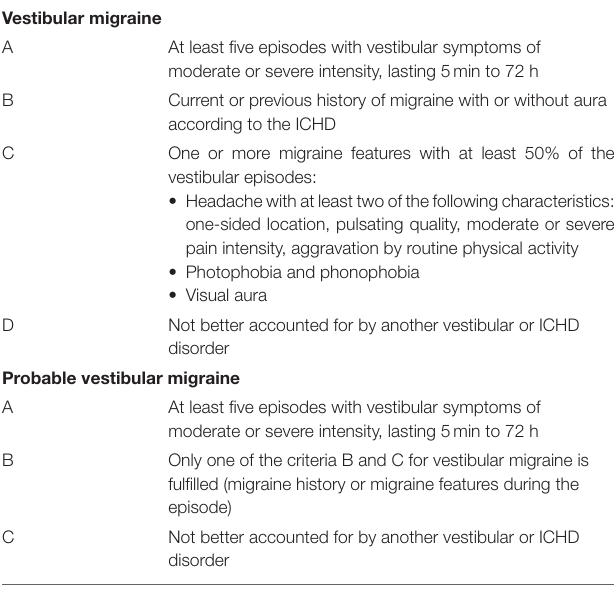
TABLE 1 | Diagnostic criteria for vestibular migraine and probable vestibular migraine adapted from Lempert et al. (2). Vestibular migraine A At least five episodes with vestibular symptoms of moderate or severe intensity, lasting 5min to 72 h B Current or previous history of migraine with or without aura according to the ICHD C One or more migraine features with at least 50% of the vestibular episodes: